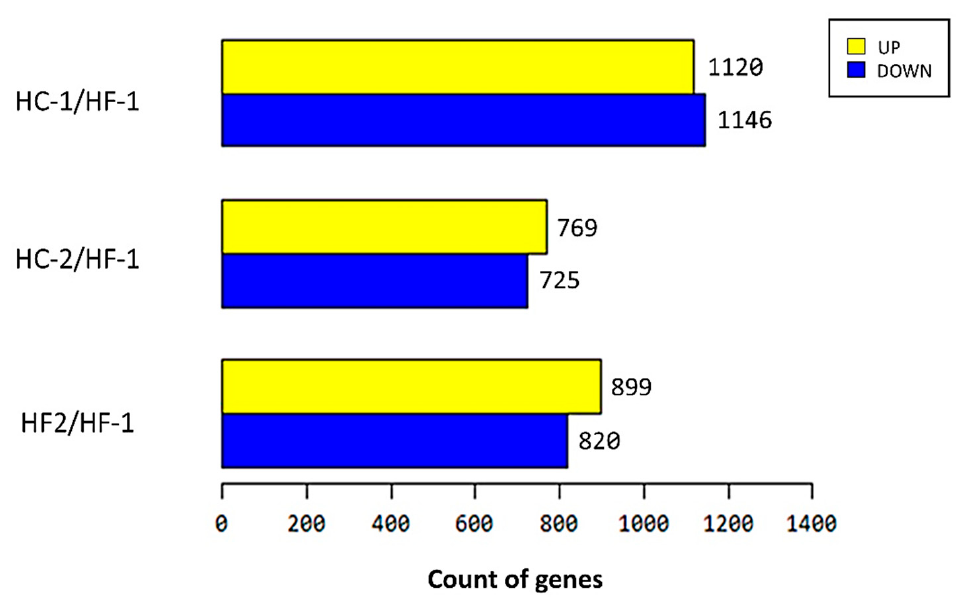
Figure 5. The differentially expressed genes’ (DEGs) up- and down-regulated count among HF-1 (control), HC-1, HC-2, and HF-2 groups. The Y-axis represents up- and down-regulation of DEGs between control vs. treatment groups. The X-axis represents the total number of transcripts (DEGs for each pairwise comparison was selected at FC > = 2). HF-1, high-forage diet (served as control group); HC-1, high-concentrate diet; HC-2, high-concentrate diet; HF-2, high-forage diet.